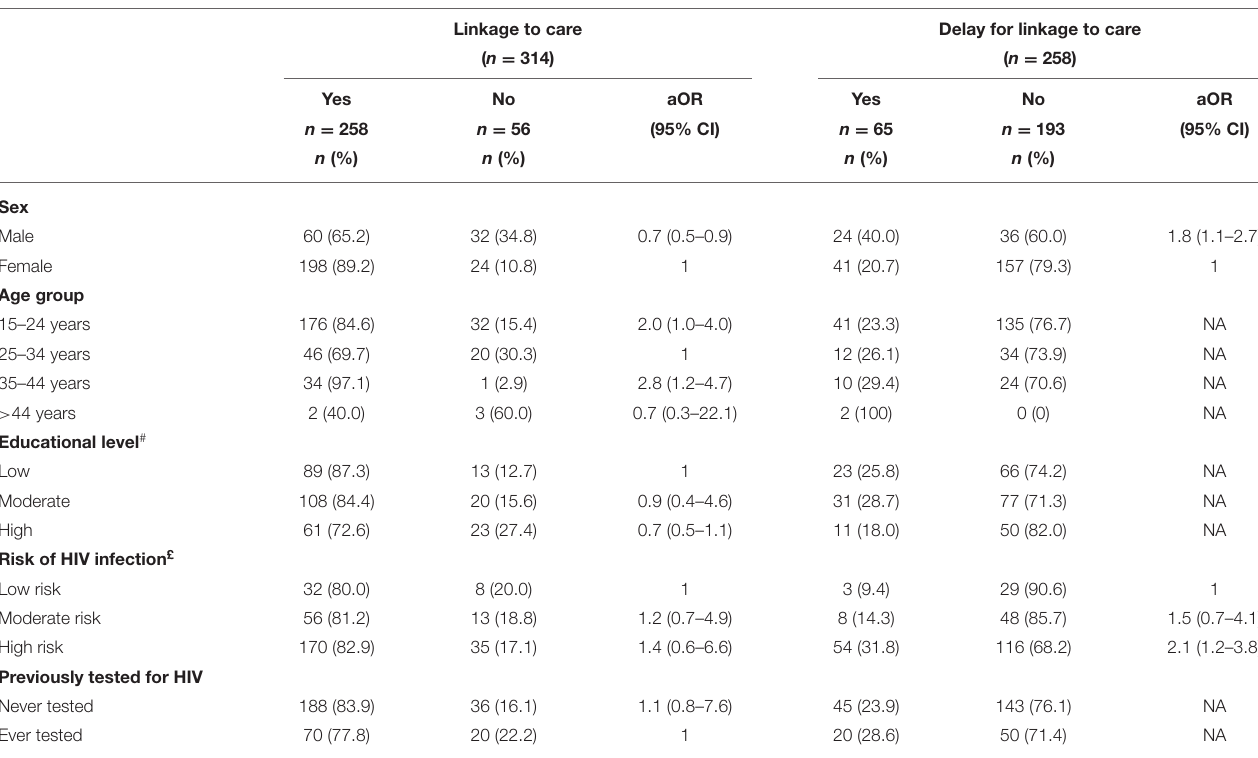
TABLE 2 | Factors associated with linkage to care among 314 participants interpreting their self-test results as positive and to delay for linkage to care among 258 participants linked to care. Linkage to care Delay for linkage to